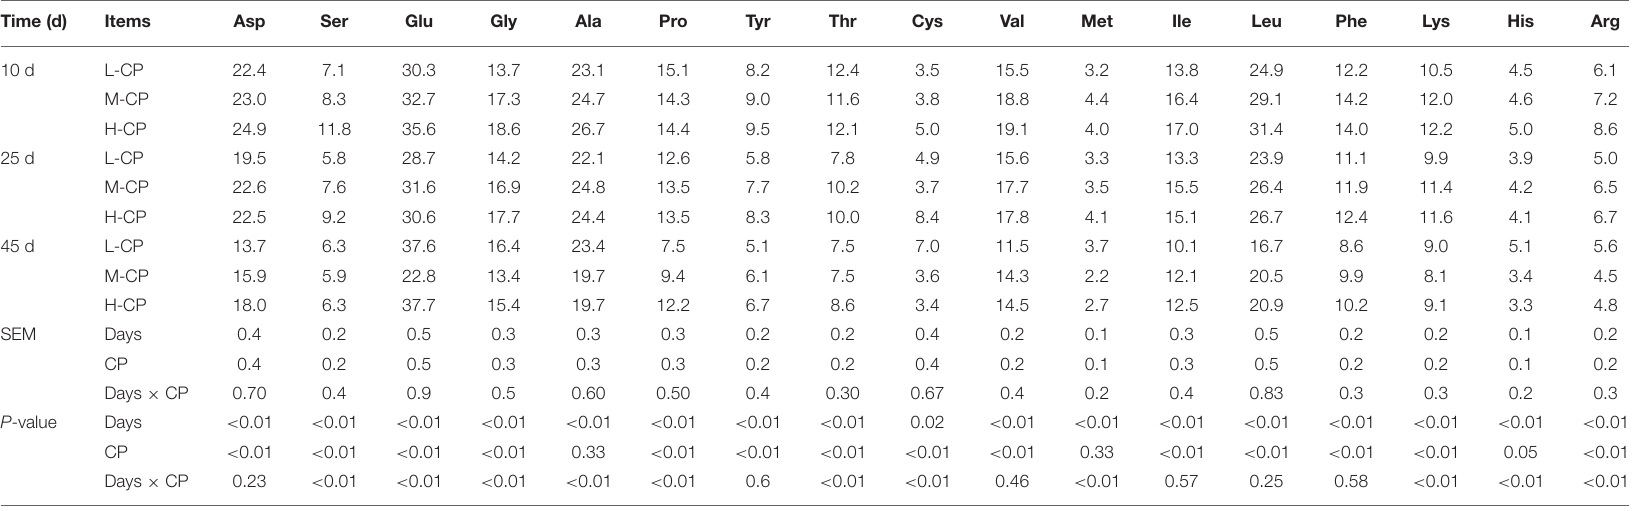
TABLE 4 | Effects of dietary protein levels on the excretion of the amino acid in feces of piglets (mg/g DM). Time (d)